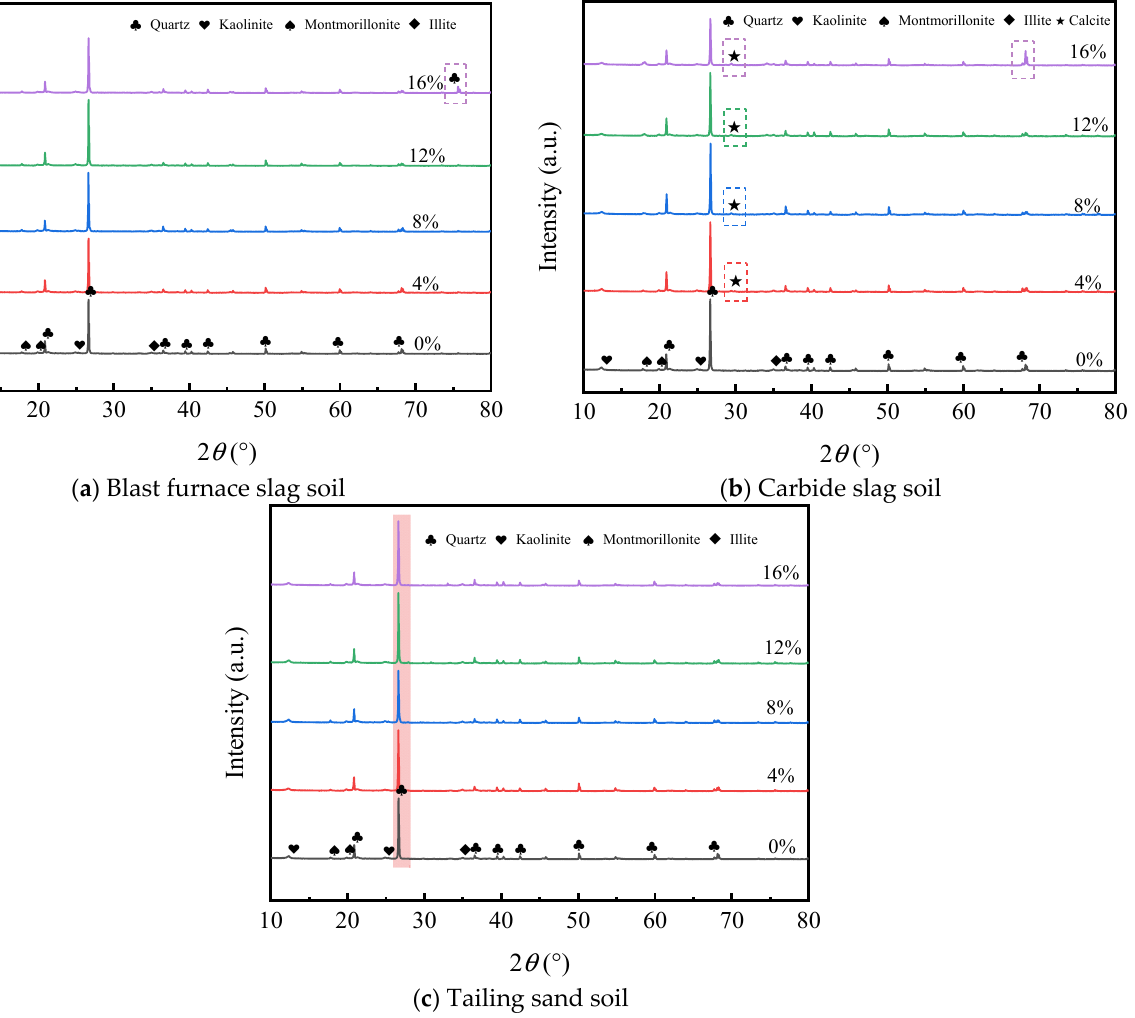
Figure 10. X-ray diffraction patterns of different waste residues soils.